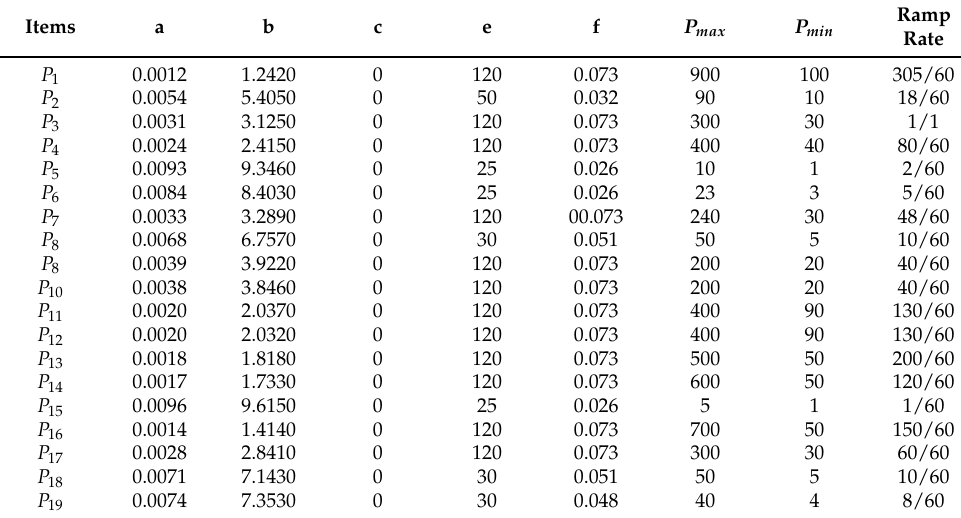
Table A1. Cost coefficients and unit characteristics of Case 1.